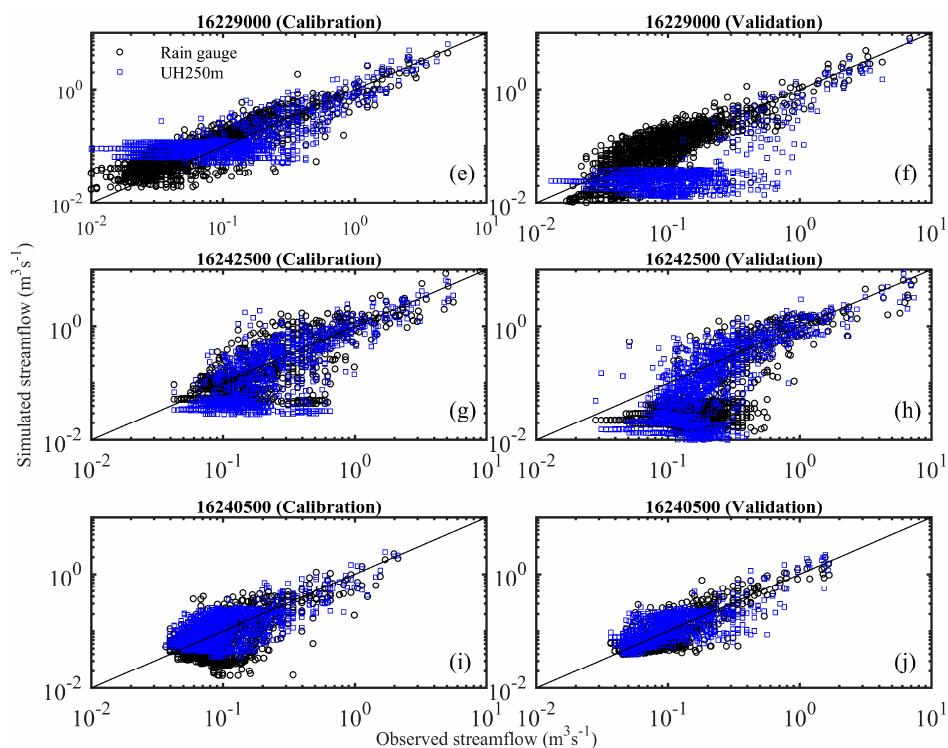
Figure 7. Scatter plots of observed and simulated daily streamflows at various stations for the calibration and validation periods of Heeia ( a – d ) and Nuuanu area ( e – j ) watersheds. Black circles refer to when rain gauge data were used while blue squares represent when the 250 m resolution data were used as rainfall input. Water 2018 , 10 , x FOR PEER REVIEW